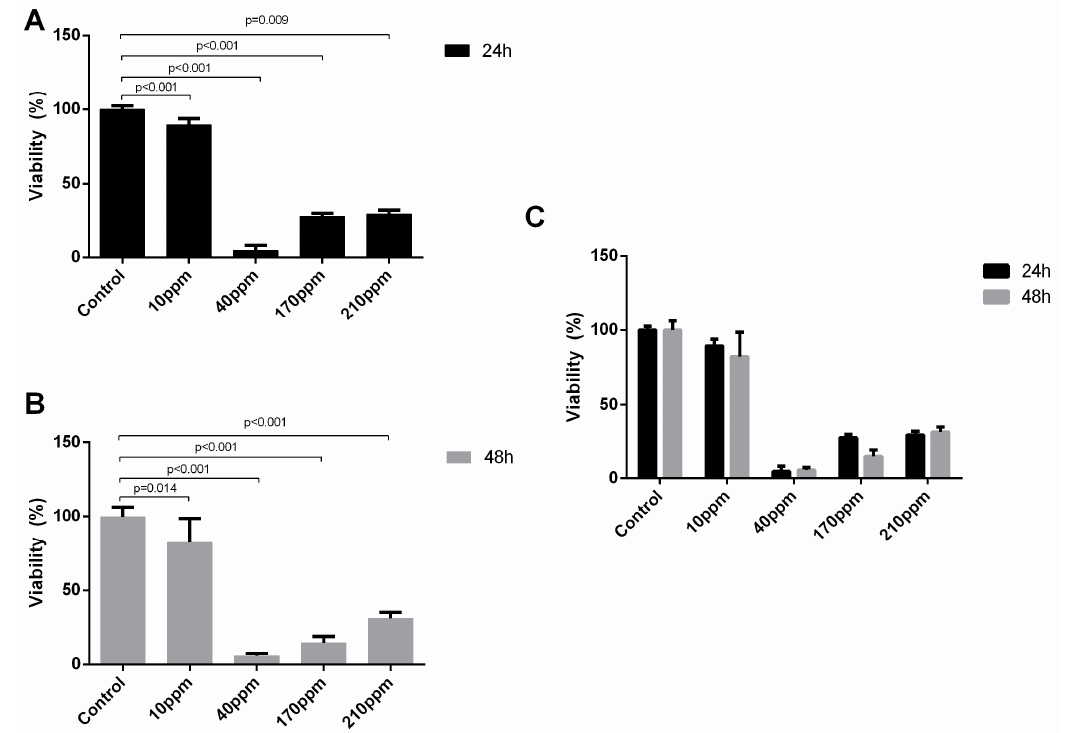
Figure 7. Evaluation of cell viability, by WST-1 assay, upon PC-3 cells treatment with AgNPs at concentrations of 10–210 ppm for 24 h ( A ) and 48 h ( B ) and the comparison between their effect at the two time points ( C ). Results are expressed as percentage of control (untreated cells), as mean ± SEM.